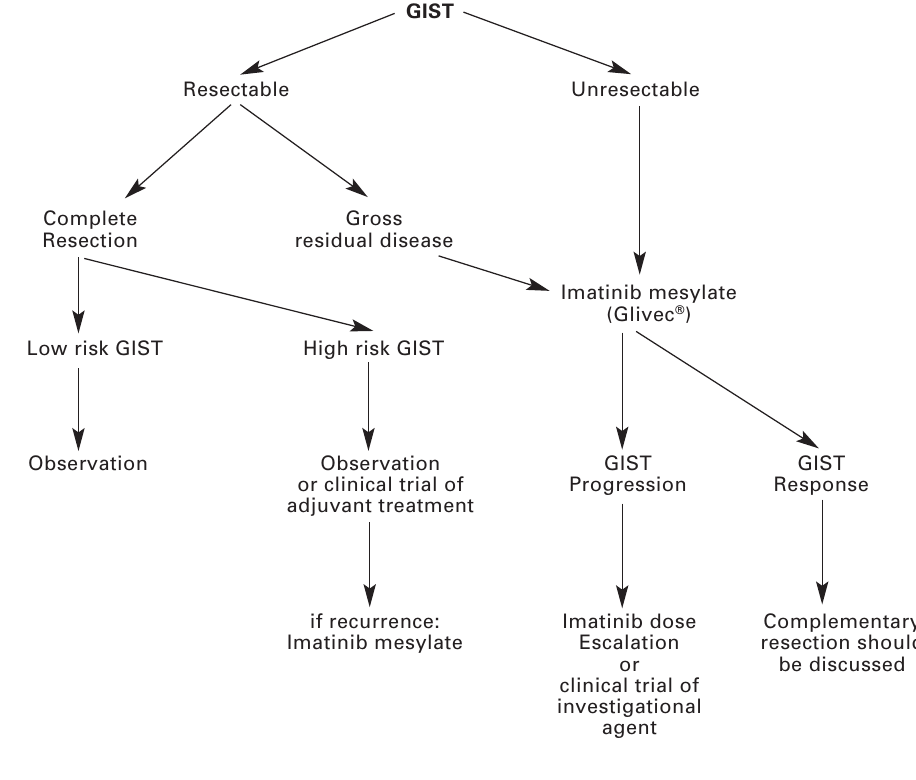
Figure 2 Treatment algorithm for patient with pri- mary presentation of